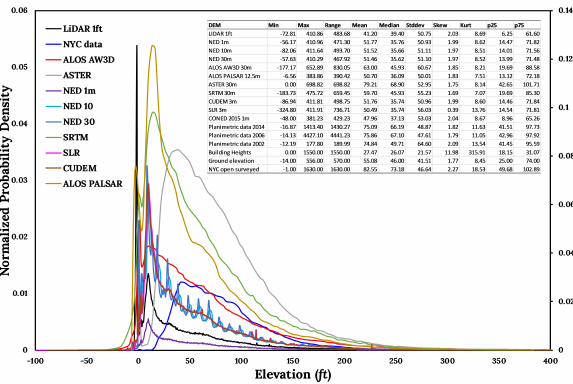
Figure 3. The distribution of elevation values for all considered datasets with histogram curves and statistical matrices table York, than other high-resolution datasets. The ASTER and SRTM have also shown relatively little steeper slopes around the buildings. The NED 10, 30m, and ALOS PALSAR did not indicate steeper slopes, indicating that these DEMs represent the smooth topography than rugged surfaces.